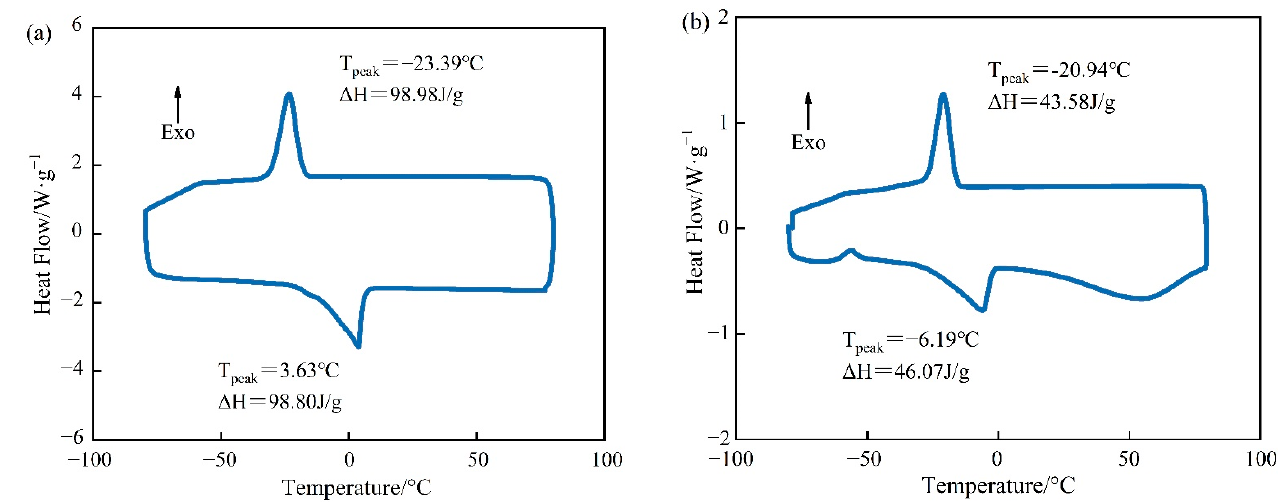
Figure 5. DSC curves of PCM for ( a ) pure PEG-400 and ( b ) PEG-400/SiO 2 composite shaped PCM.